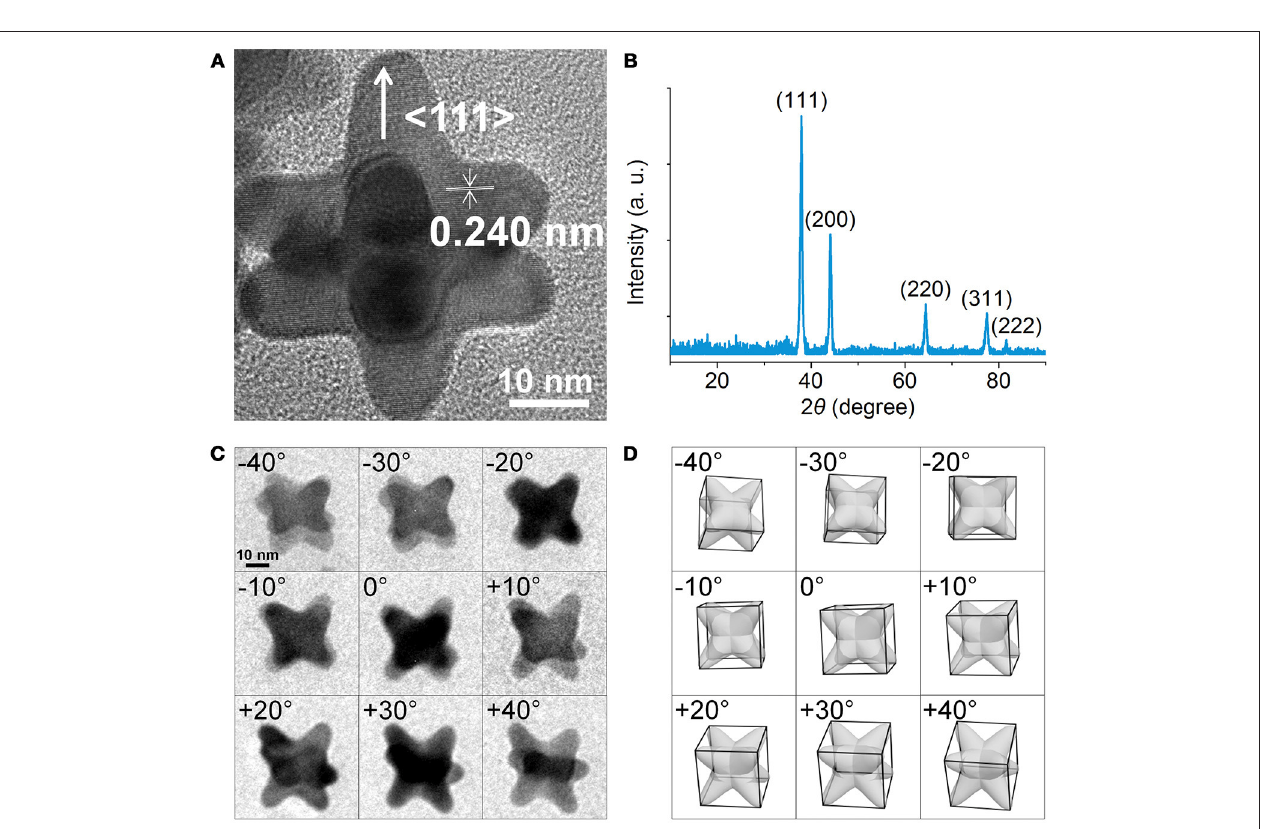
reduction rate, V dep ≪ V diff , most of the adatoms at the corners will migrate to edges and side facets, and the growth will prevail along the < 100 > and < 110 > directions, leading to the formation of Wulff shape (Xia et al., 2015), as favored by thermodynamics